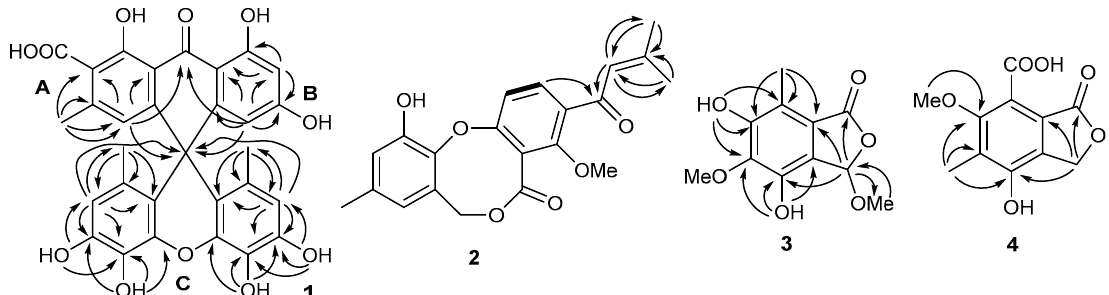
Figure 2. 1 H- 1 H correlation spectroscopy ( 1 H- 1 H COSY) and key heteronuclear multiple bond correlation (HMBC) Figure 2. ¹H-¹H correlation spectroscopy (¹H-¹H COSY) and key heteronuclear multiple bond correlation (HMBC) corre- lations of 1 – 4 . correlations of 1 – 4